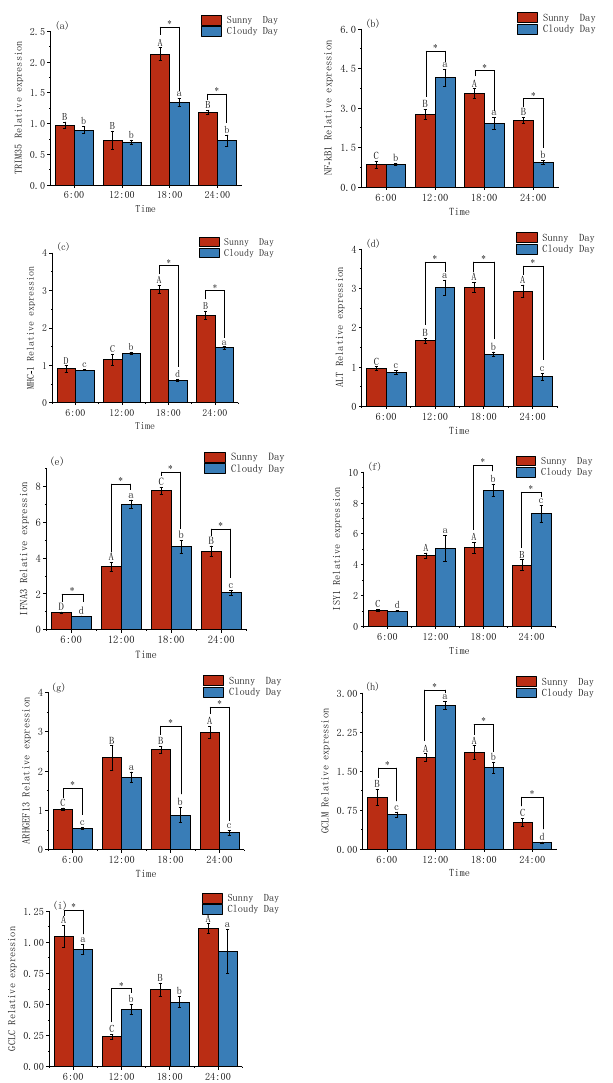
Figure 3. Expression of liver immune genes in different weather conditions in mackerel tuna over a 24 h period. ( a ): TRIM35 ; ( b ): NF-kB 1; ( c ): MHC-I ; ( d ): ALT ; ( e ): IFNA3 ; ( f ): ISY1 ; ( g ): ARHGEF13 ; ( h ): GCLM ; ( i ): GCLC . Red in each graph represents sunny days, and blue represents cloudy days. The presence of different letters indicates significance by ANOVA and Tukey’s tests ( p < 0.05). * repre- sents significant differences at the same time point ( p < 0.05).